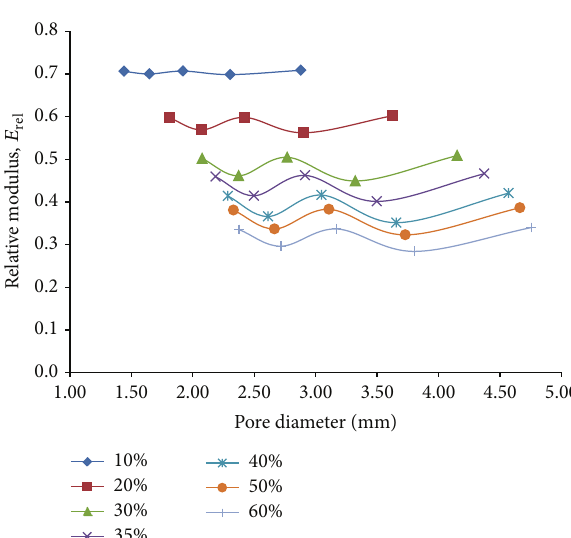
Figure 8: Plots depicting variation of relative modulus, 𝐸 rel , with pore diameter for different percentages of porosity, using 3D porous FE cube models under compressive loading only.